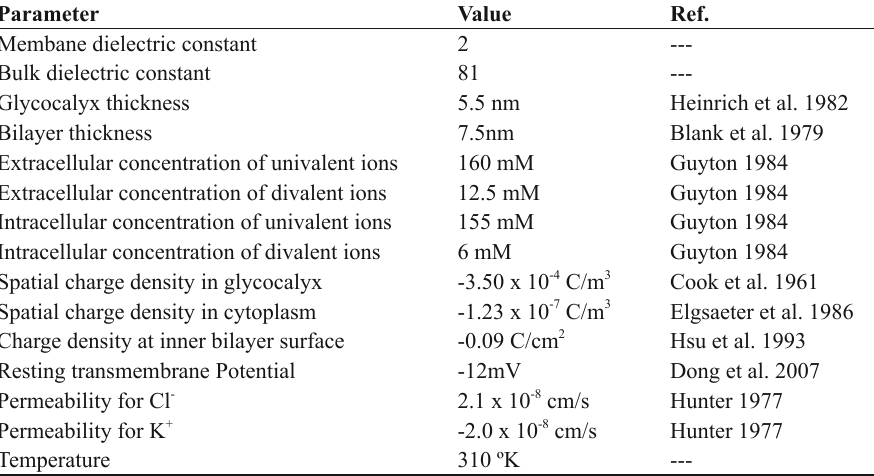
Values of parameters used for calculation.